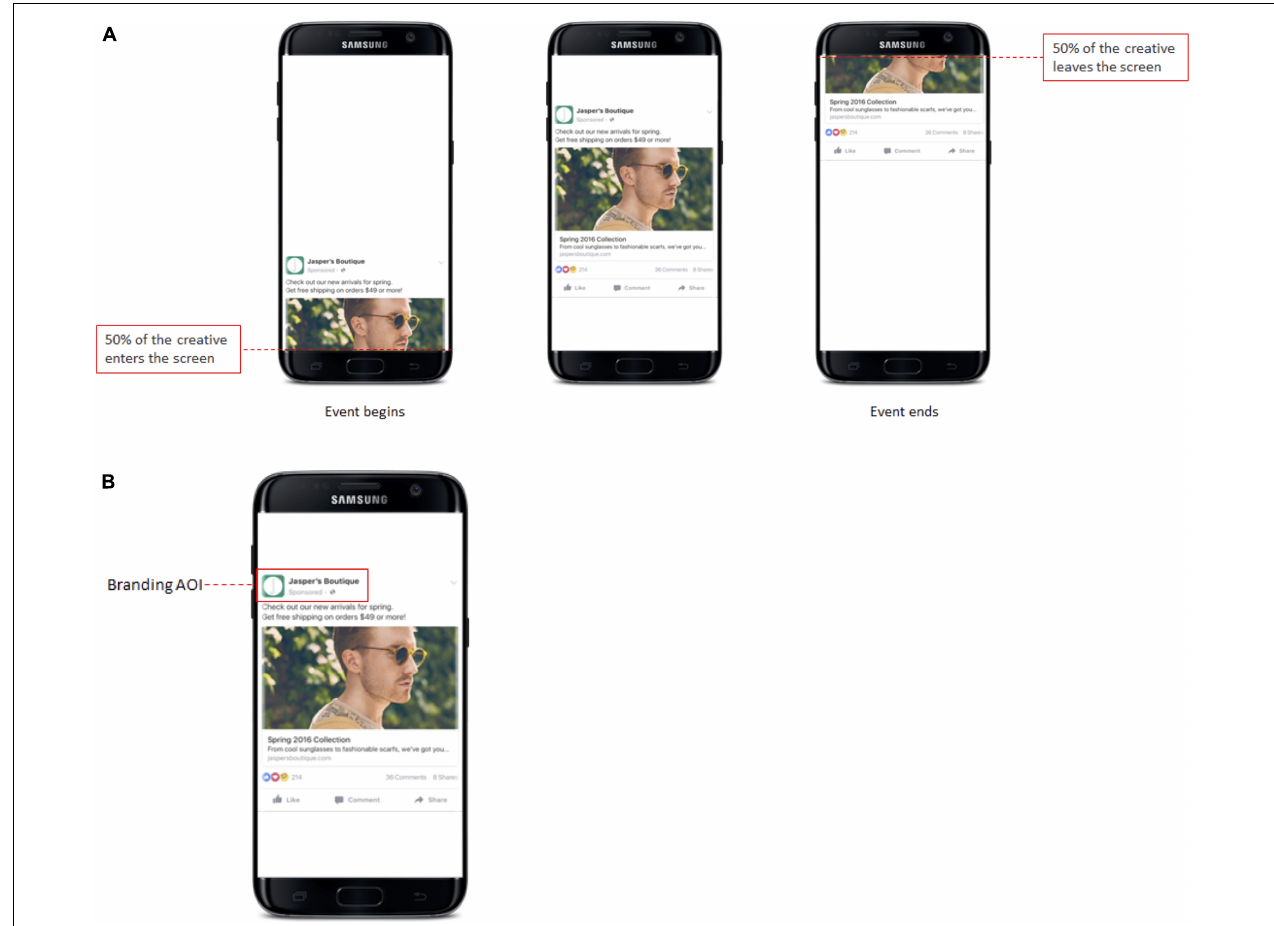
FIGURE 3 | (A) A visualization of annotating the onset and endpoint of a stimulus as an example of placing the beginning and end of events. (B) An example of Branding